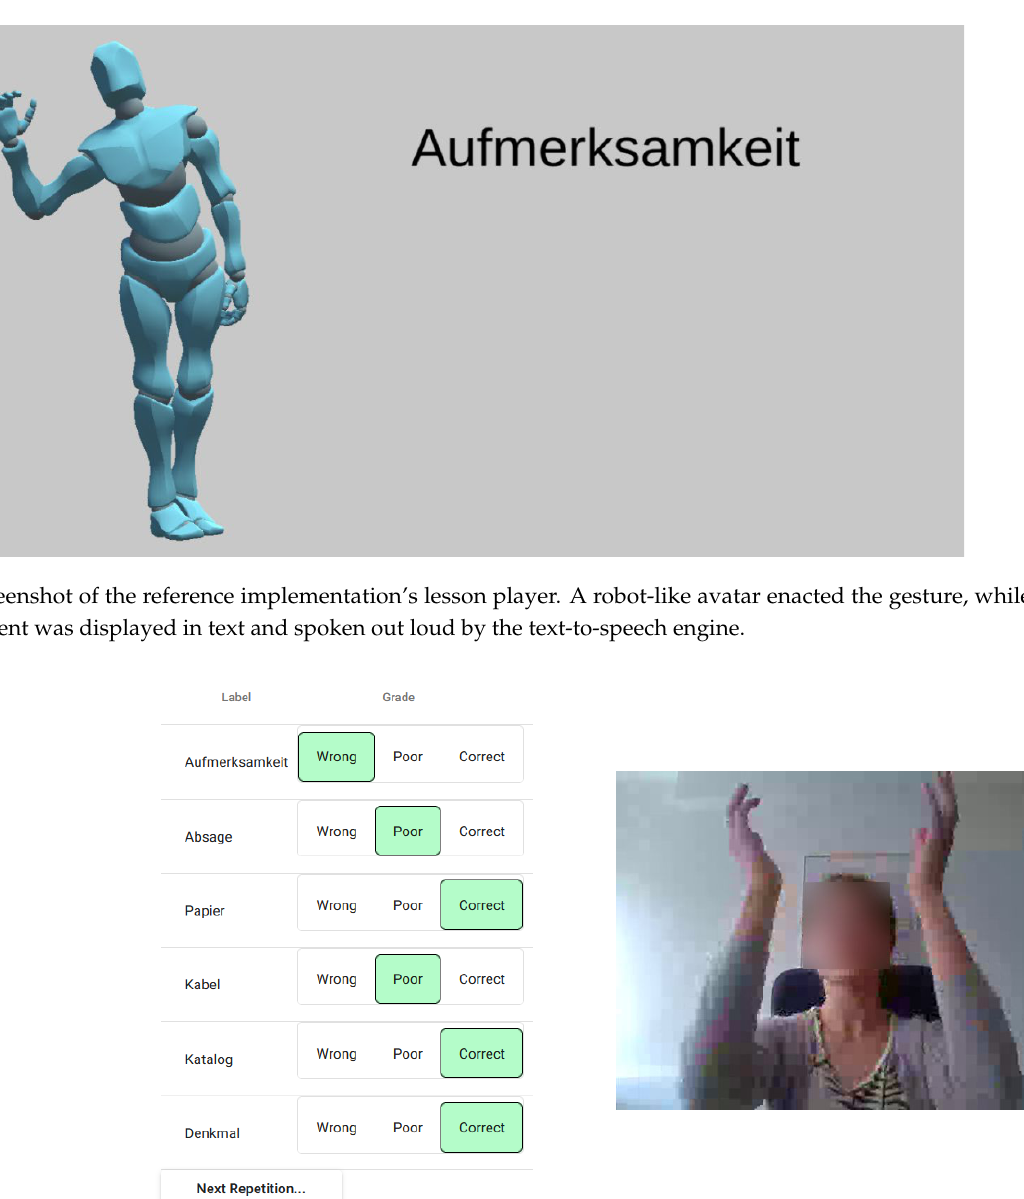
Figure 4. Screenshot of the reference implementation’s lesson configurator. GECs could be created by drag-and-drop of the content and gesture cards. Hovering over a gesture card previewed the gesture.